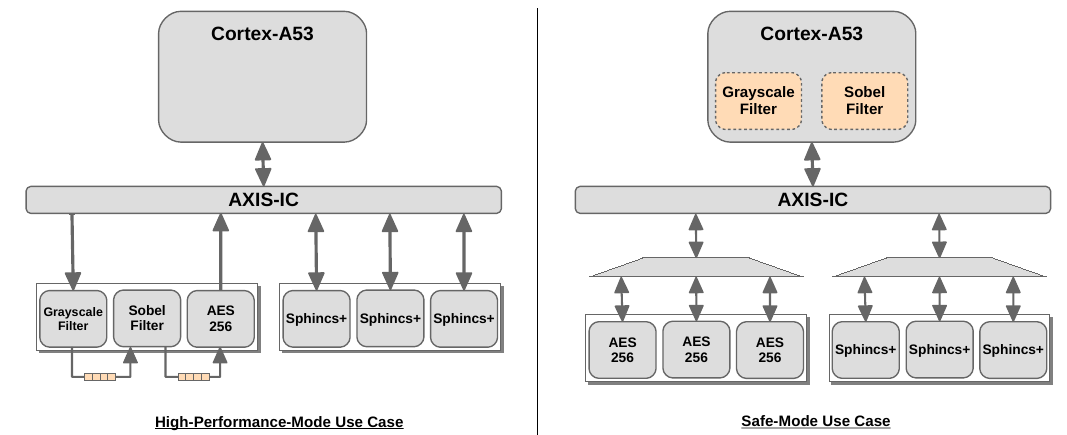
Figure 7. Operation modes use